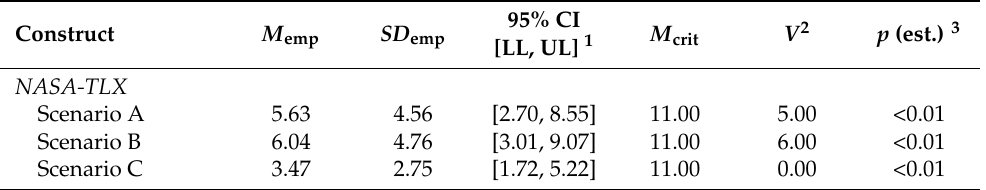
Table 10. Descriptive and inferential statistics regarding capacity.